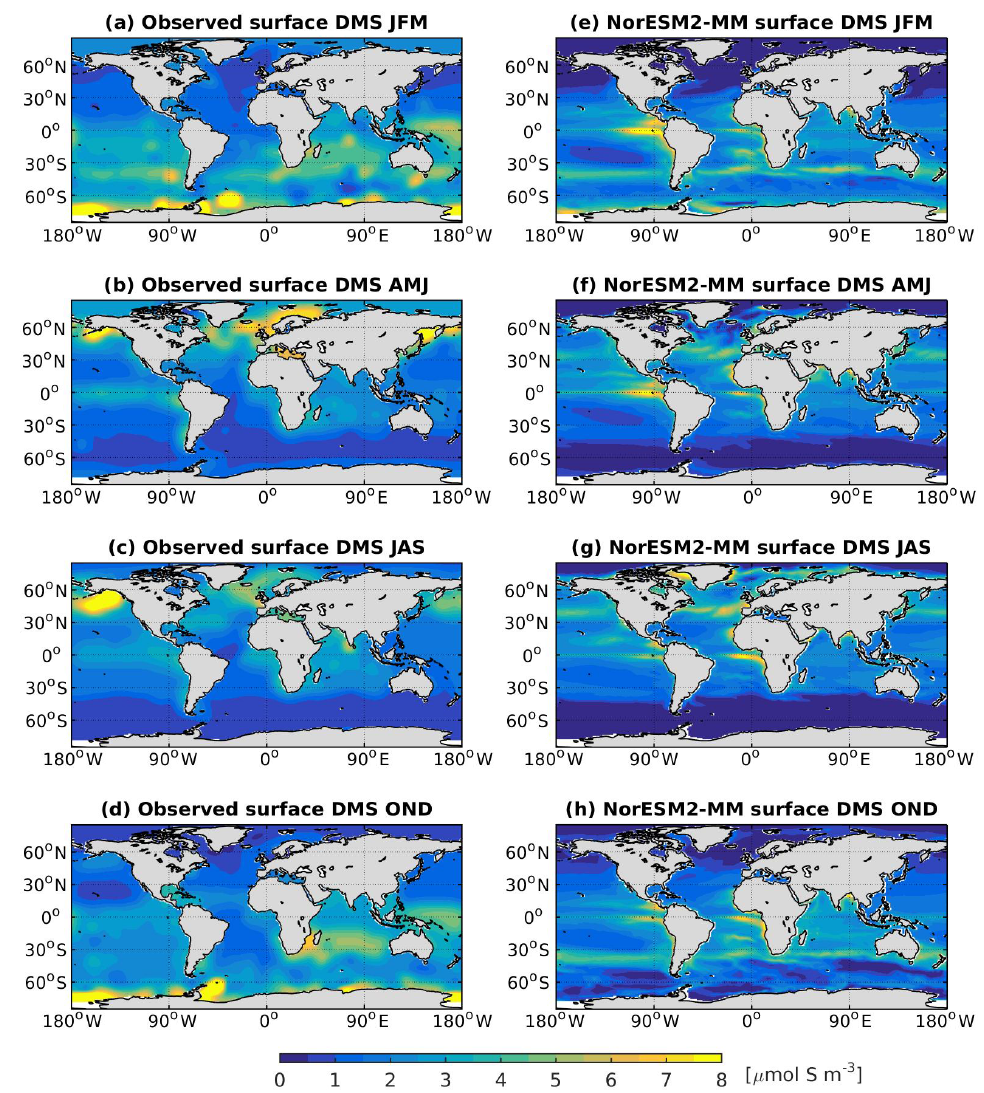
Figure 15. Seasonally averaged surface concentration of DMS from observations (a–d) and as simulated in NorESM2-MM (e–h) .